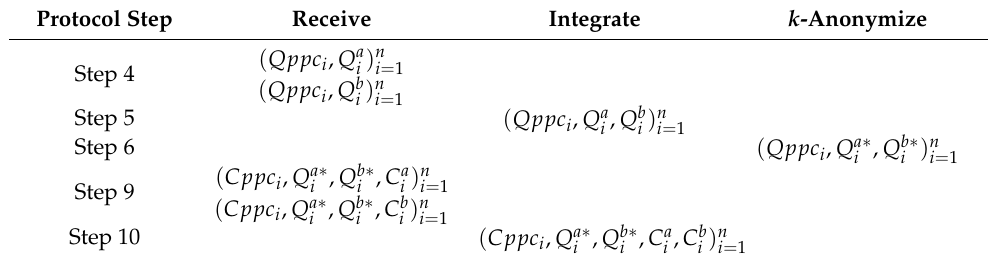
Table 3. Data handled by the mashup coordinator during the execution of the anonymization and integration